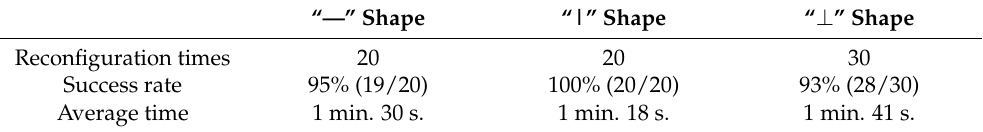
Table 3. Reconfiguration speed.